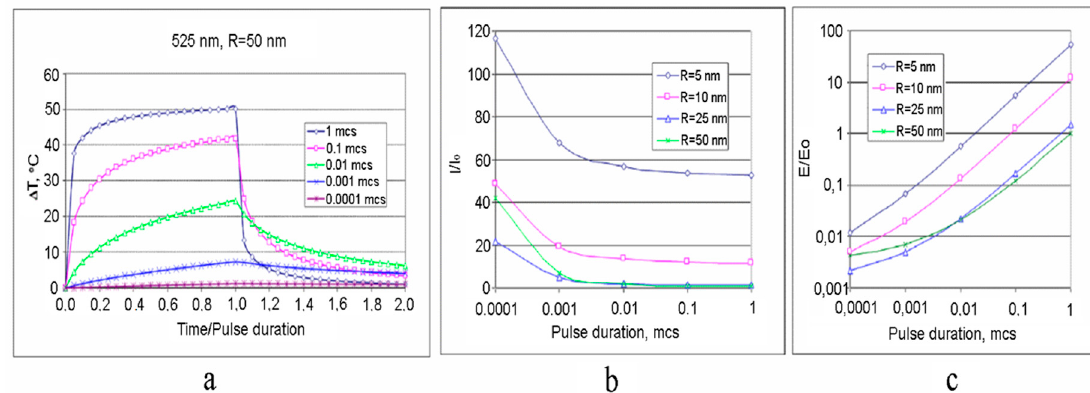
Figure 6. Temporal temperature evolution for 50 nm-AuNPs under the action of pulse laser radiation ( λ = 525 nm) ( a ); The normalized power density ( b ) and pulse energy ( c ) of laser beam necessary for achieving the same temperature on the surface of AuNP, depending on pulse duration and nanoparticle radius R [52].